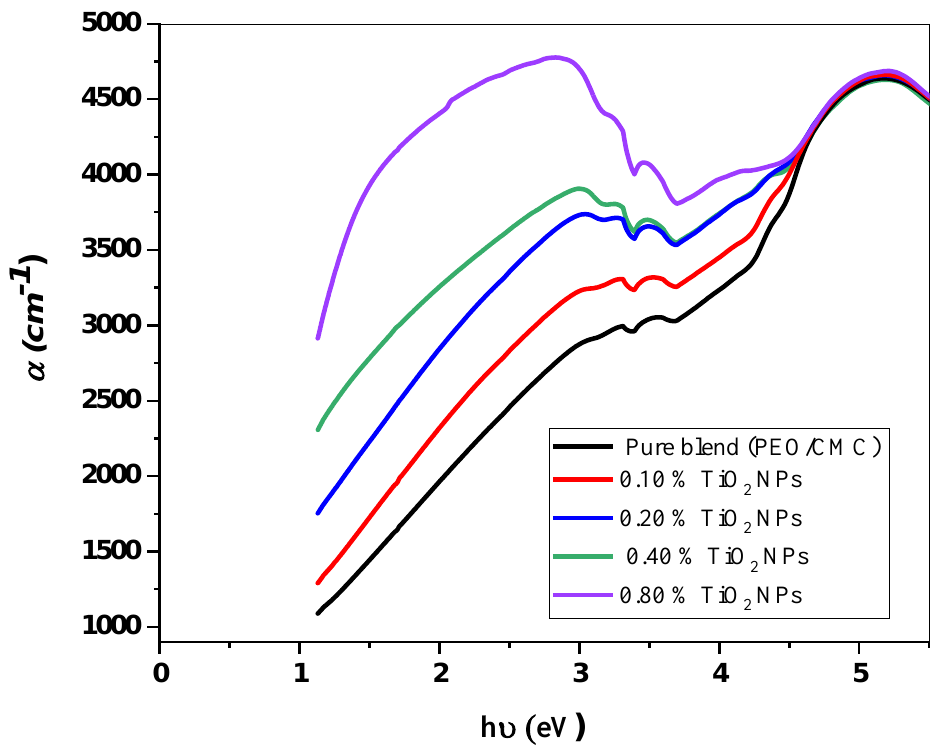
Figure 5. The relation between 𝛼(𝑣) and h 𝑣 for the PEO/CMC blend and PEO/CMC/TiO 2 NPs at various concentrations.